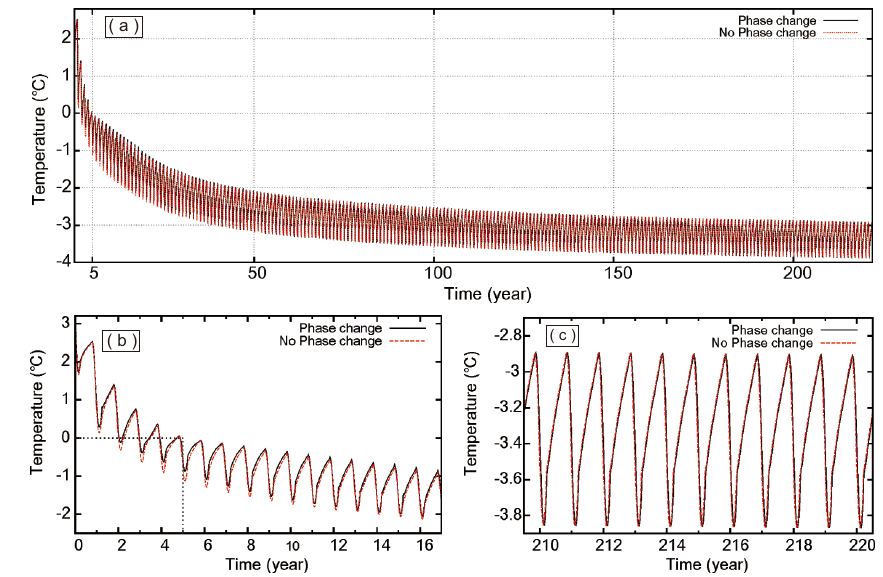
Figure 4. (a) Formation process of Ningwu ice cave, (b) initial formation process and (c) quasi-stable state.